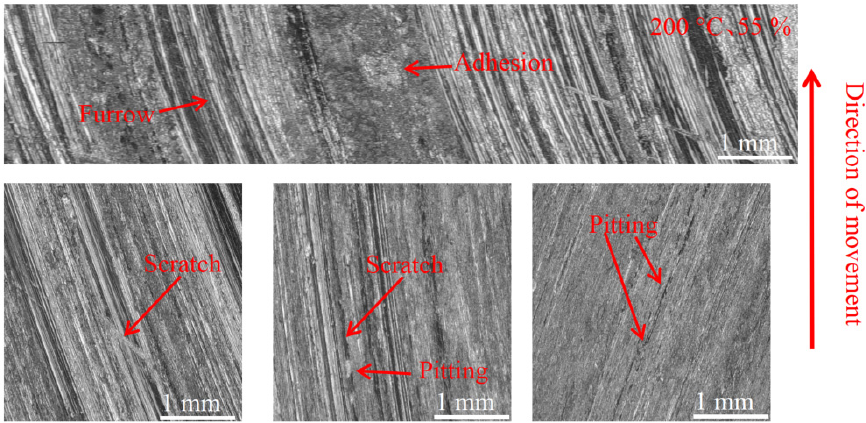
Figure 13. Surface morphology damage map of the disk at 100 °C and 55% ambient humidity.